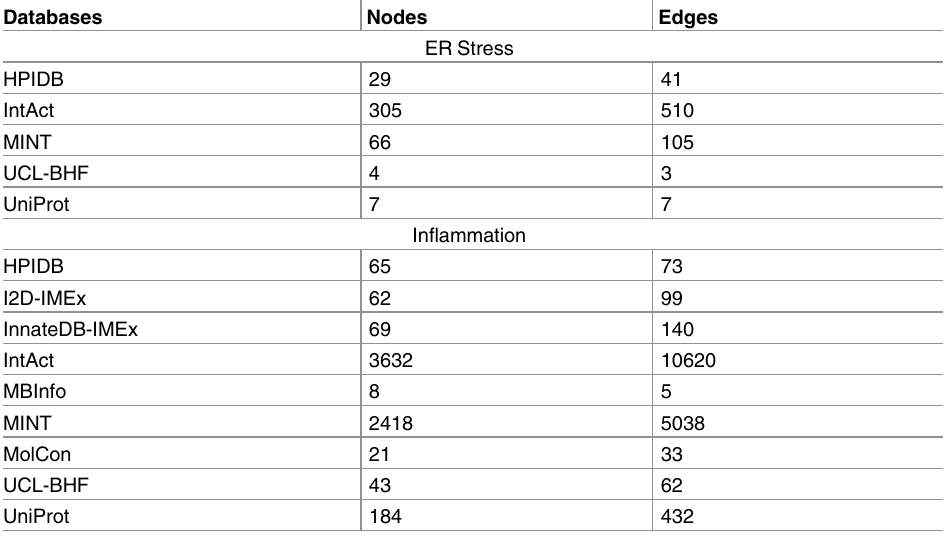
Table 2. PPI data derived from IMEx-curated databases for ER stress and inflammation in AMD.